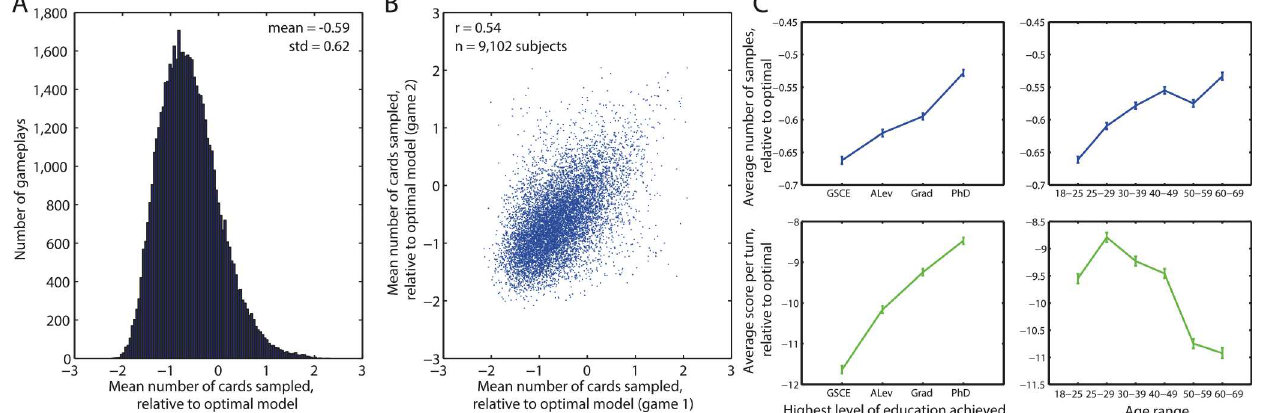
Fig 7. Individual differences in information seeking. (A) Histogram of the mean number of cards sampled in each trial relative to how many would be sampled by the optimal model. Subjects show a propensity to guess early, but there is considerable individualvariation. (B) Individual variation in information samplingreproduces across subsequent gameplays. Each dot is a subject; subjects who were inclined to seek little information in gameplay 1 also sought little information in gameplay 2. (C) Variation in information seeking (top) and subject performance (bottom) as a function of educational attainment (left panels) and age (right panels). General Certificate of Secondary Education (GCSE) is equivalentto 10th grade in United States; A Level (ALev) is equivalentto 12th grade. Datapoints denote mean +/- standard error of the mean. Data for reproducing all analysesis freely availablefor download from